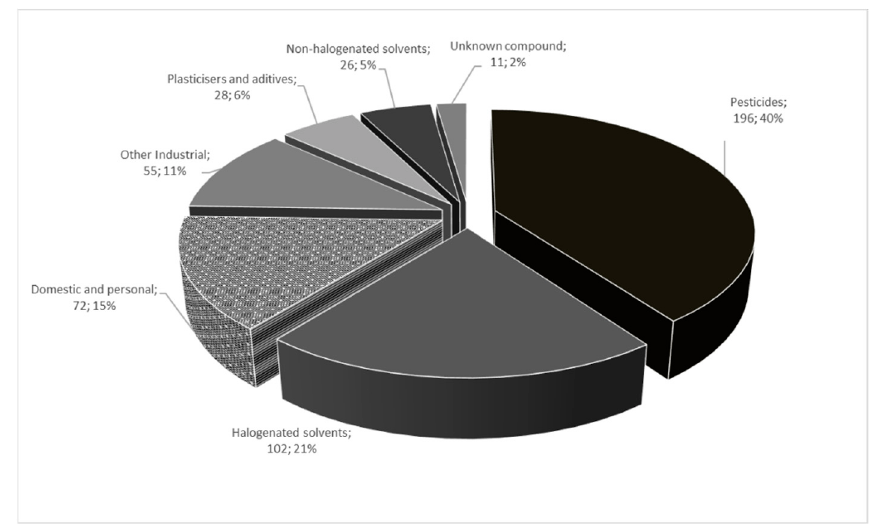
Figure 7. Identification frequency of compounds according to type and typical use.